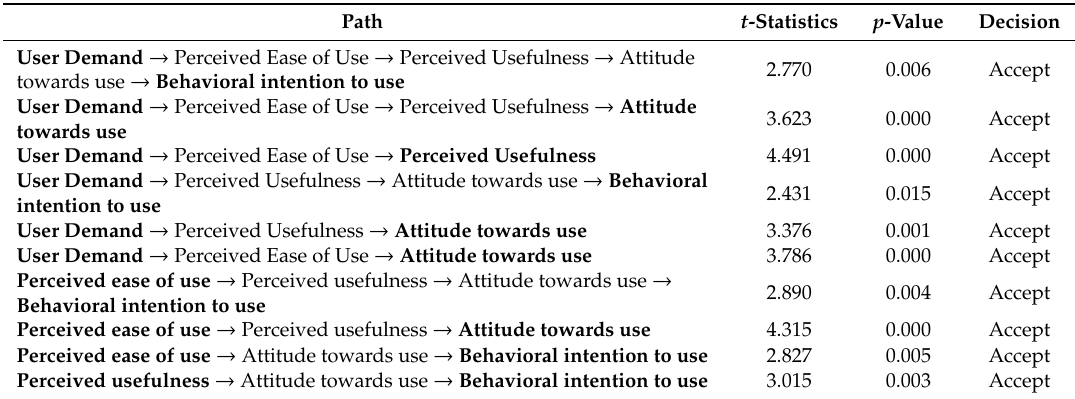
Table 13. Indirect e ff ects of the mediating variables